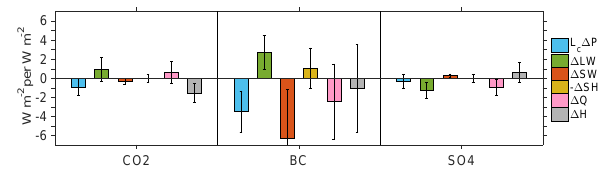
Figure 3. Domain-averaged (purple rectangles in Fig. 1) energy budget change for each forcing and energy component as shown in Eqs. (1) and (2). It holds that L c (cid:49)P ( blue ) = (cid:49)Q ( pink ) + (cid:49)H ( gray ) , where L c (cid:49)P is the change in total latent heat- ing, (cid:49)Q ( pink ) = (cid:49) LW ( green ) + (cid:49) SW ( red ) − (cid:49) SH ( brown ) is the change in diabatic cooling of the atmospheric column due to shortwave and longwave radiation, and sensible heat flux, (cid:49)H , is the change in column-integrated dry static energy flux divergence. The error bars indicated 90% inter-model